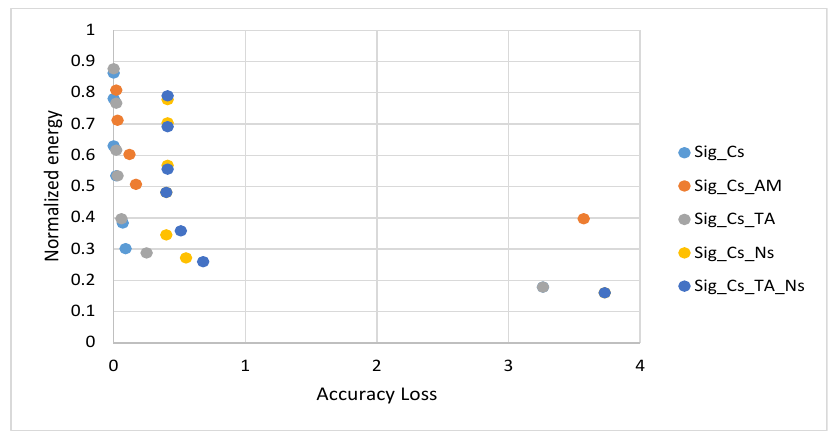
Figure 8. Configuration points used as a searching space to choose the suitable implementation at a given energy for MNIST dataset, sig: Sigmoid activation function, Cs: Computation skipping, AM: Approximate Multiplier, TA: Truncated Accumulation, Ns: Neuron skipping.